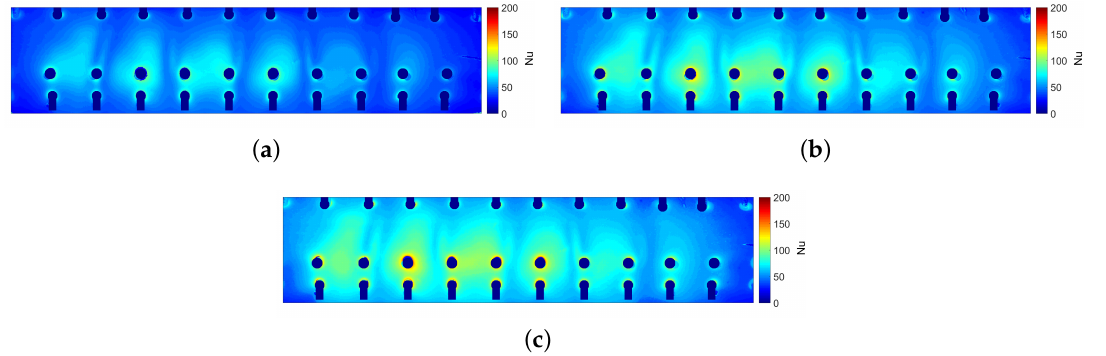
Figure 6. Comparison of measured Nusselt number distributions for geometry 1 with Re = 13,000, 17,500 and 22,000. ( a ) Re = 13,000; ( b ) Re = 17,500; ( c ) Re = 22,000.